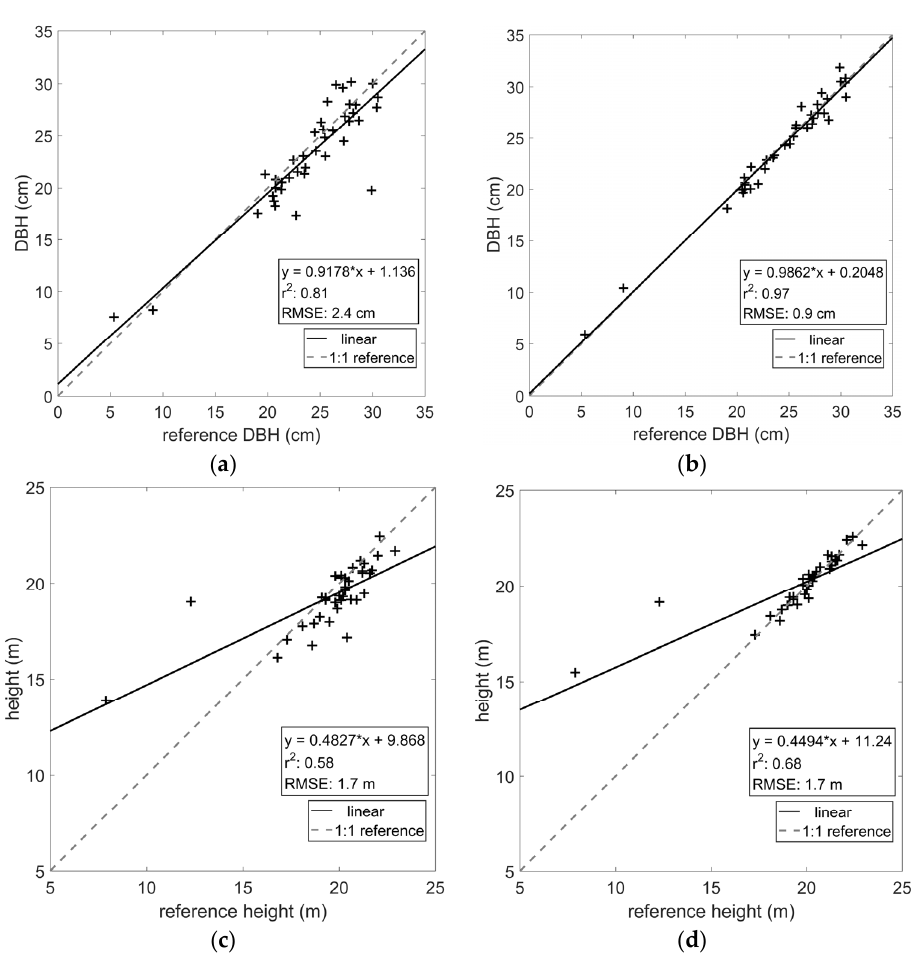
Figure 8. Scatter plot between the measured and the extracted: ( a ) DBH from single scan (SS); ( b ) DBH from MS; ( c ) height from SS; ( d ) height from MS.